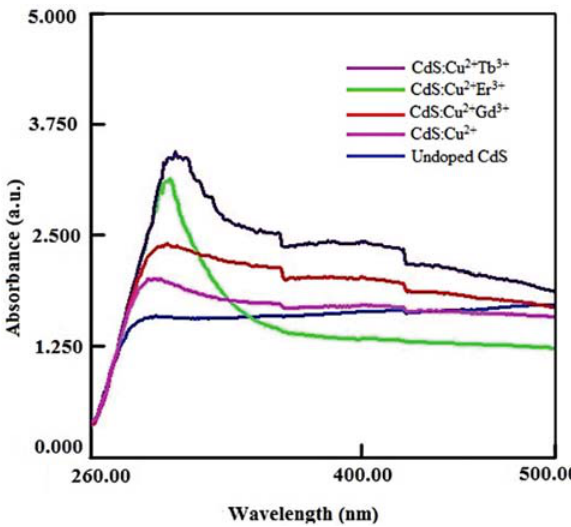
Figure 6. Absorption spectra for (a) undoped CdS (b) CdS:Cu 2+ (c) CdS:Cu 2+ Gd 3+ (d) CdS:Cu 2+ Er 3+ (e) CdS:Cu 2+ Tb 3+